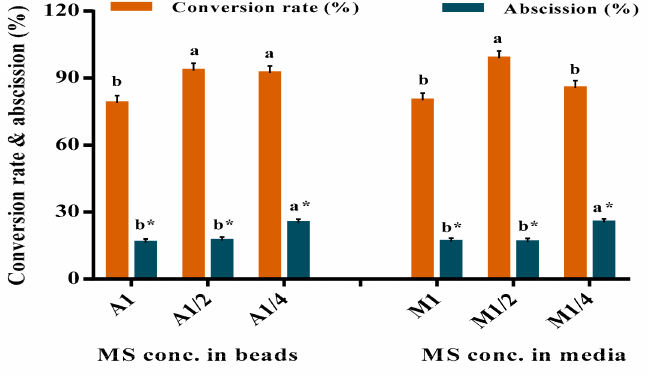
Figure 4. Effect of MS salts concentration on encapsulated vegetable sweet potato ( Ipomoea batatas L.) nodes on plantlets conversion rate and leaf abscission. Full MS in the capsule (A1), 1 / 2 MS in the capsule (A1/2), 1 / 4 MS in the capsule (A1/4). Full MS salts in growth media (M1), 1 / 2 MS salts in growth media (M1/2), 1 / 4 MS salts in growth media (M1/4). (*) indicate a significant interaction between the evaluated parameter at a 5% probability level. Means with a different letter within the bars differ significantly at a 5% probability level using